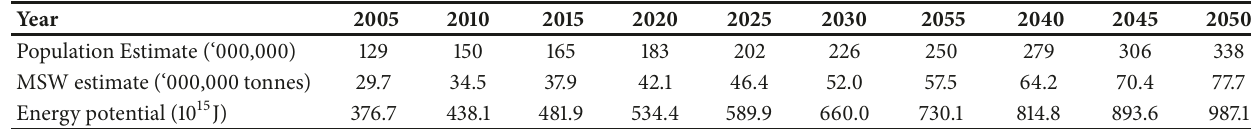
Table 6: Energy potential of municipal solid wastes in Nigeria.